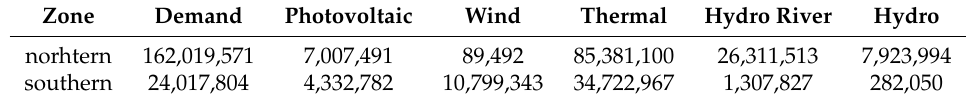
Table 1. Total demand and total energy production from renewable sources for the year 2019, in MWh. Zone Demand Photovoltaic Wind Thermal Hydro River Hydro norhtern 162,019,571 7,007,491 89,492 85,381,100 26,311,513 7,923,994 southern 24,017,804 4,332,782 34,722,967